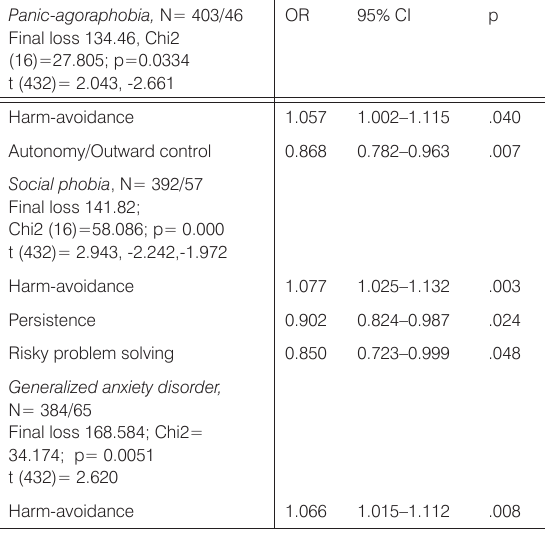
Table 1. Independent effects of variables on distinct anxiety syndromes* Panic-agoraphobia, N= 403/46 Final loss 134.46,